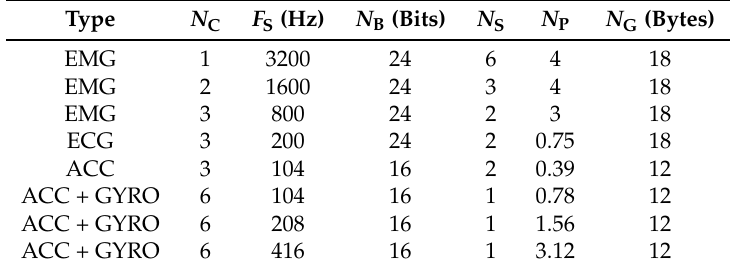
Table 3. Sampling and buffering strategies for a few different combinations of data to be streamed and ODR, which fits within the limits of BLE